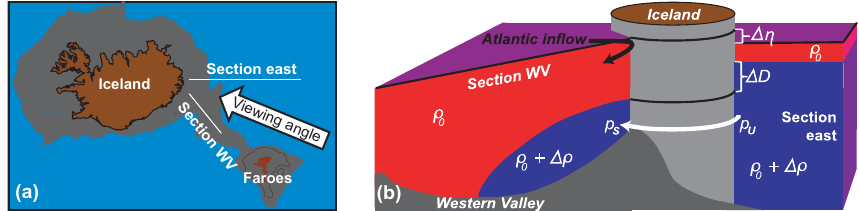
Figure 15. (a) The Iceland–Faroe region with two sections indicated by white lines: one going eastwards (section east) and one crossing the WV (section WV). (b) An idealized sketch of the two sections as seen from the Norwegian Sea towards Iceland (viewing angle in panel a ). The ocean is approximated as a two-layer system with density difference (cid:49)ρ . The Atlantic inflow turns southwards after passing through the WV, which is associated with a sea level difference (cid:49)η between the two sections (Fig. 3). The thick white arrow illustrates a water parcel of dense water flowing along the Icelandic slope from east of Iceland through the WV without changing depth. Ignoring friction, the Bernoulli equation gives the acceleration of the water parcel in terms of the pressure change along the path, which may be expressed as (cid:49)p = p U − p S = g · ((cid:49)ρ · (cid:49)D − ρ 0 · (cid:49)η) .